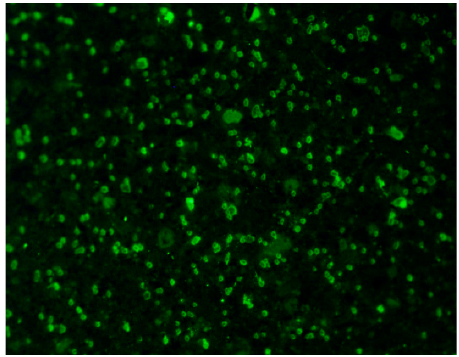
Figure 3. Fluorescence image of the cross-section of the ruptured specimen after tensile test.